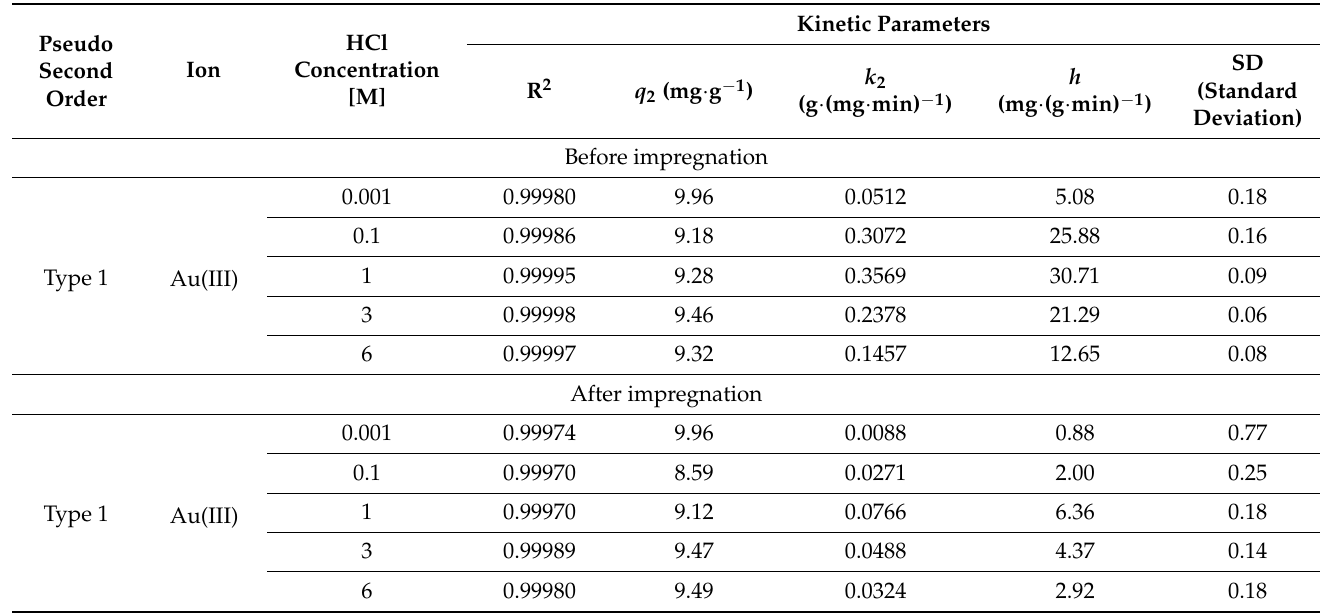
Table 1. Kinetic parameters for the unmodified Purolite MN 202 and after the impregnation with Cyanex 272 determined from the results obtained using the static